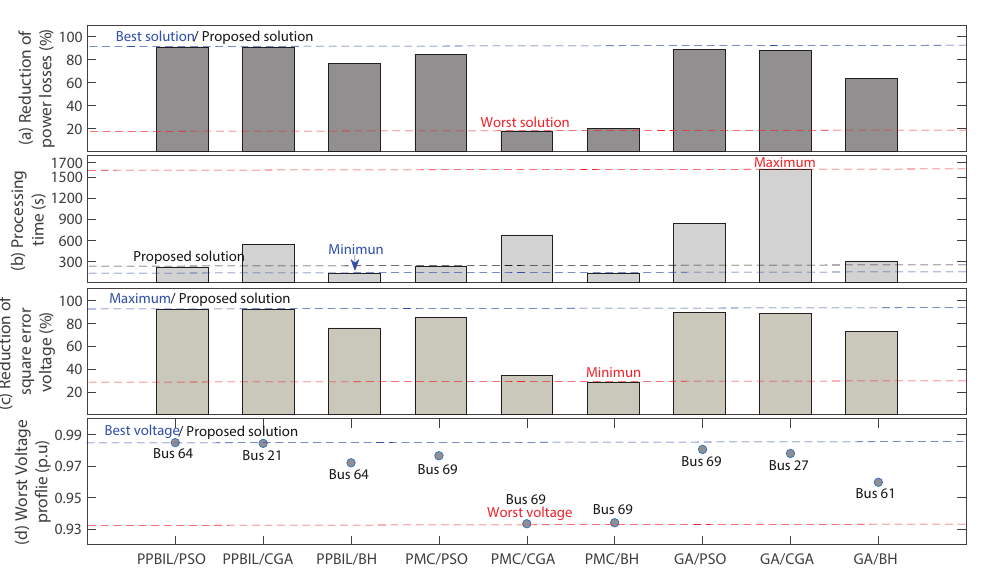
Figure 11. Results obtained with the 69 bus test system. ( a ) Reduction of power losses (%); ( b ) Processing Time (s); ( c ) Reduction of square error voltage (%); ( d ) Worst Voltage profile (p.u).